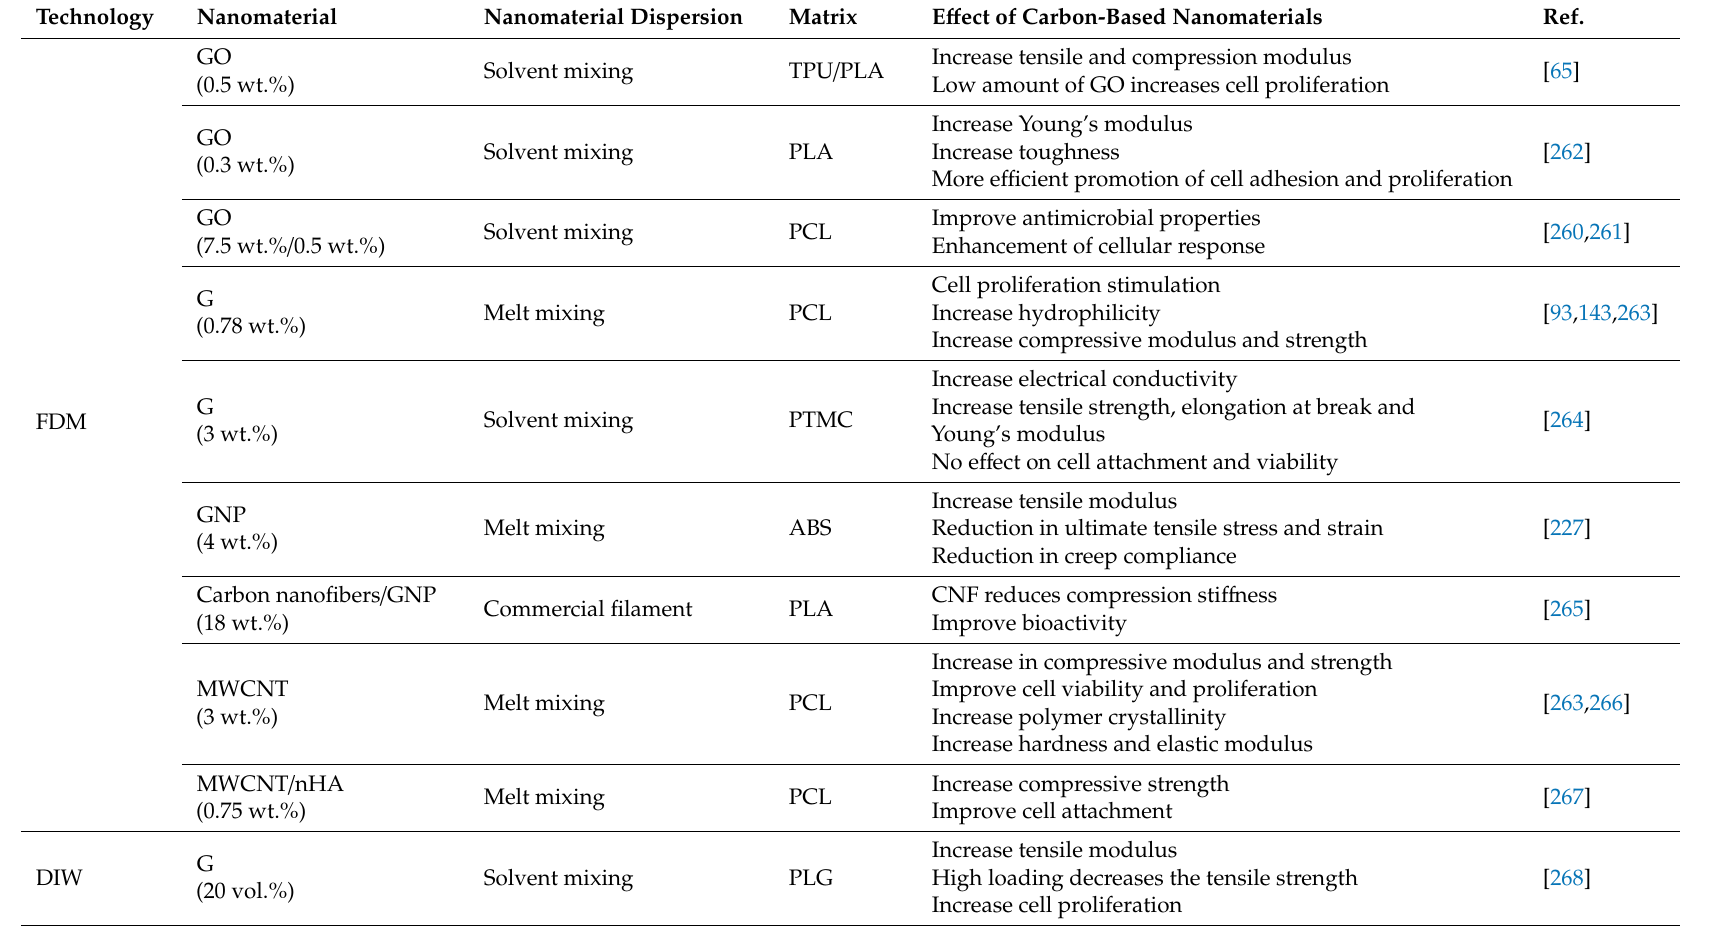
Table 3. Polymer sca ff olds obtained by 3D printer with di ff erent carbon-based